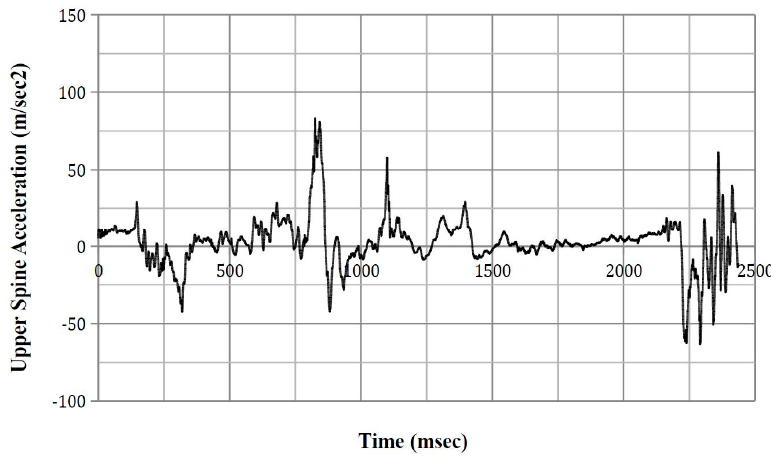
Figure A14. ATD Position 1 lower spine acceleration.